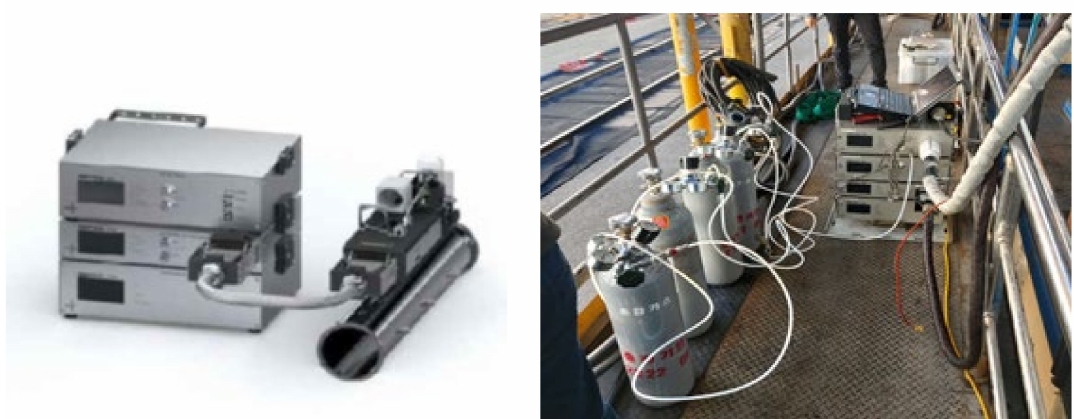
Figure 2. Photographs of the portable emission measurement system